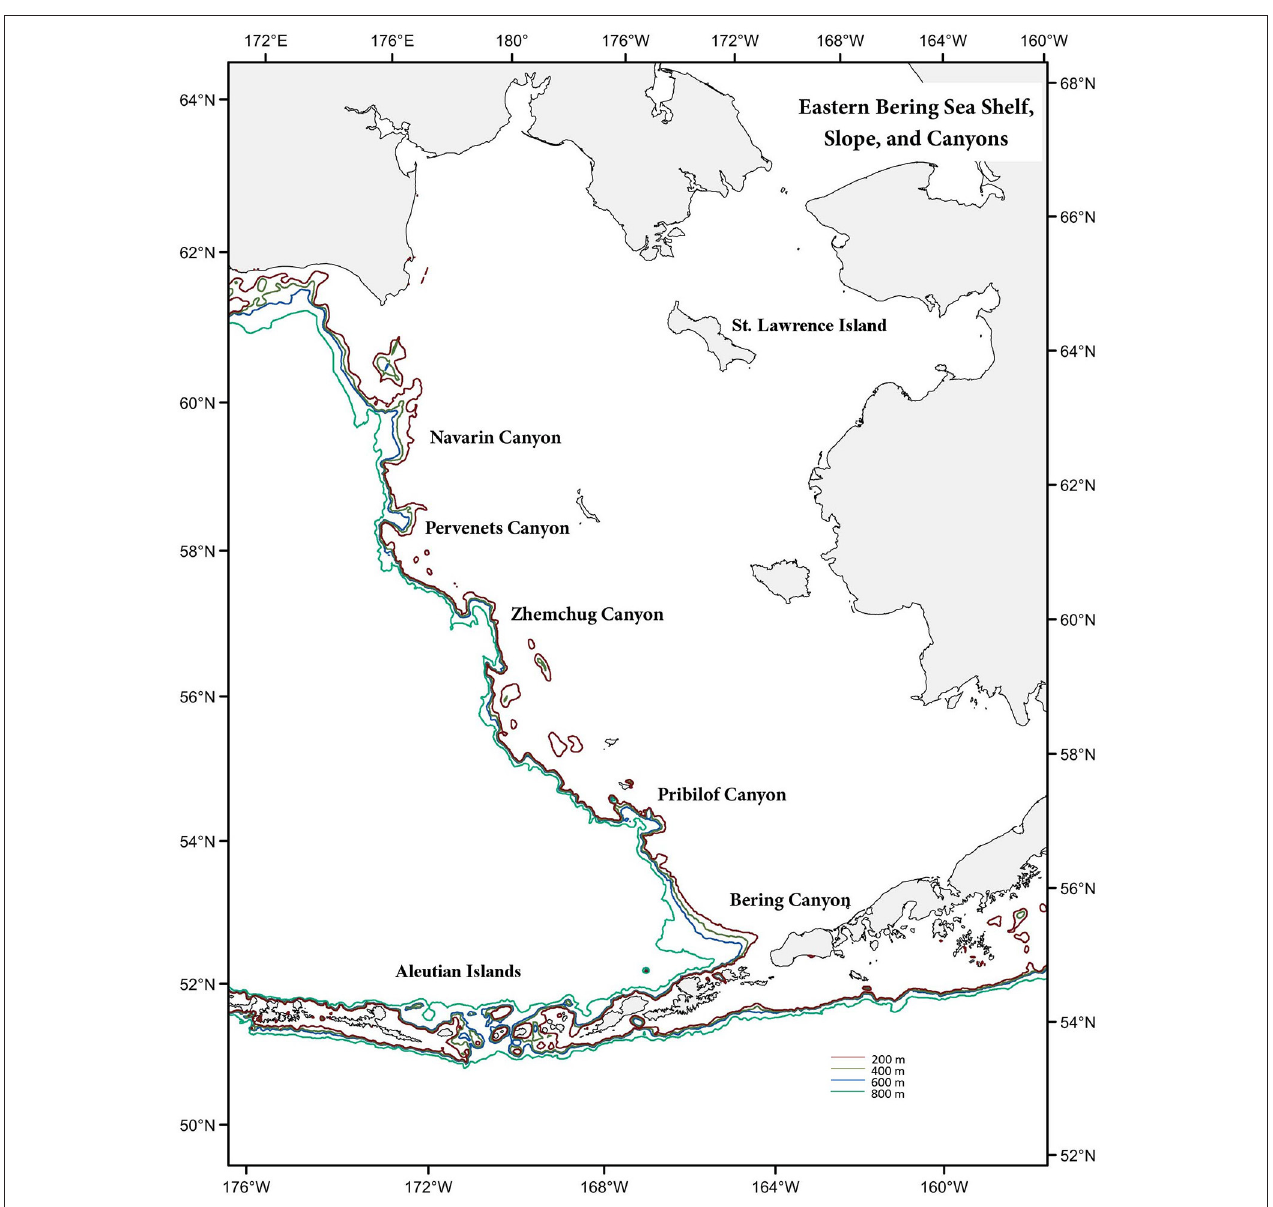
FIGURE 1 | Eastern Bering Sea showing the locations of the five major